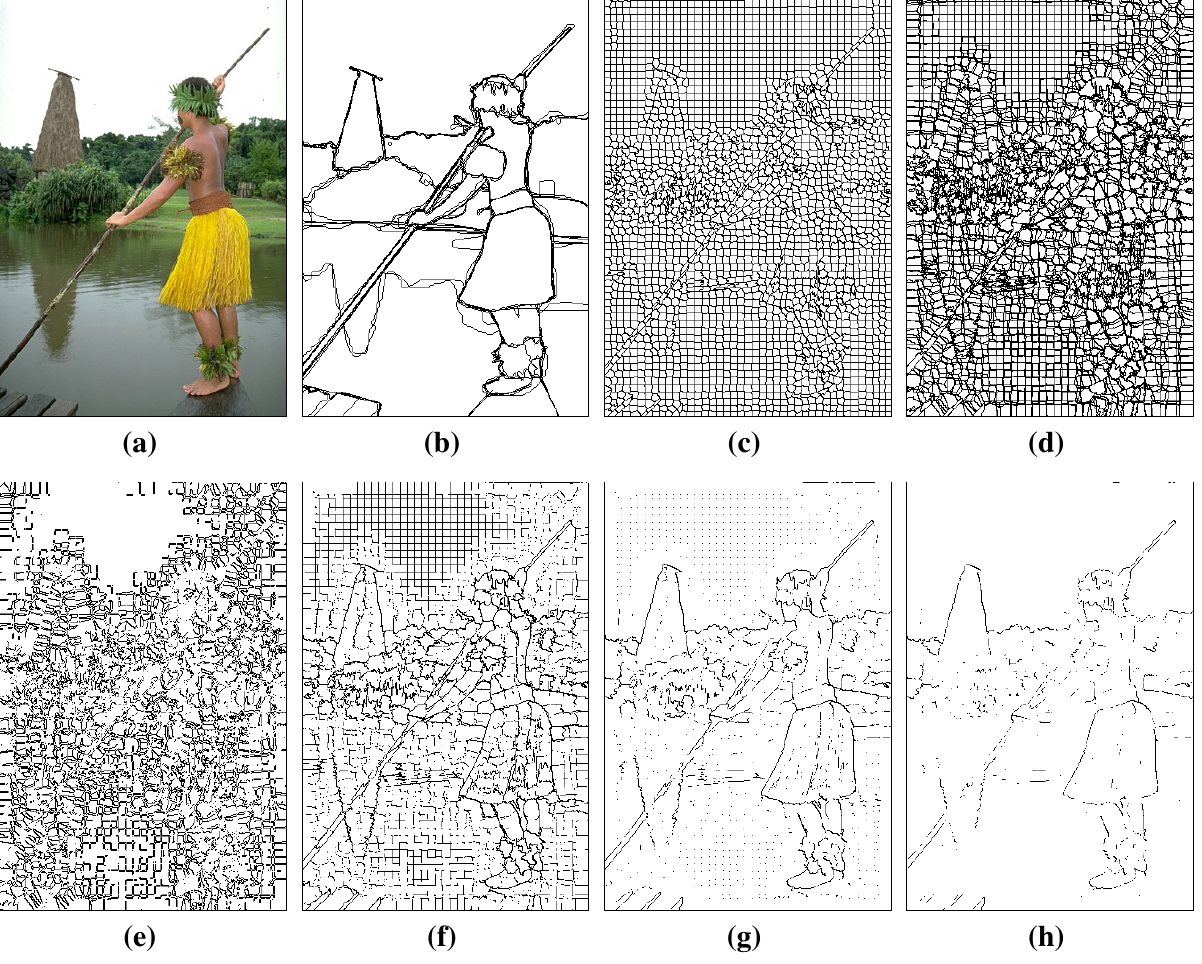
Figure 2. Contour candidates generated by original SLIC and our modified SLIC. ( a ) Input image; ( b ) ground truth; ( c ) contour candidates generated by original SLIC; ( d ) contour candidates generated by our modified SLIC, superimposed on all of the contour candidates over this image; ( e ) Pixels appear only once in contour candidates; many of them are clutter or meaningless textures; ( f )–( h ) Pixels appear more than once, twice and three times; pixels of meaningful contour are preserved to be candidates with different